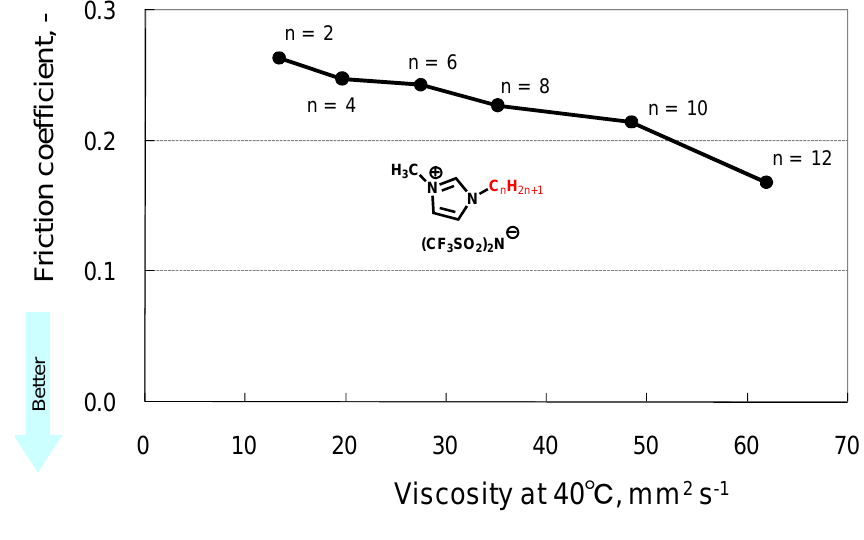
Figure 1. Effect of chain length in imidazolium cation on friction.